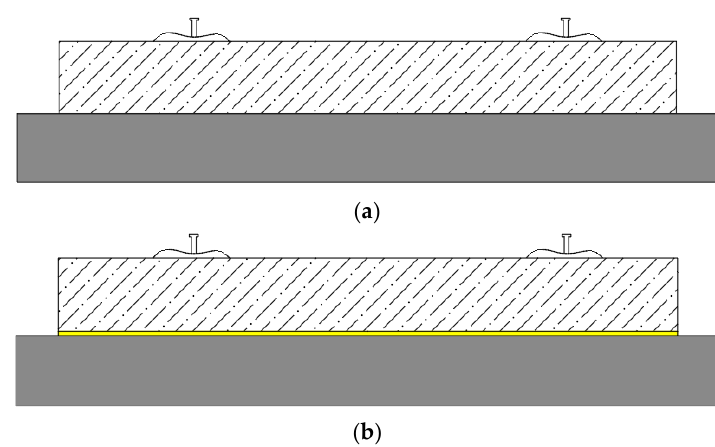
Figure 5. Working condition . ( a ) Without mat. ( b ) With mat.